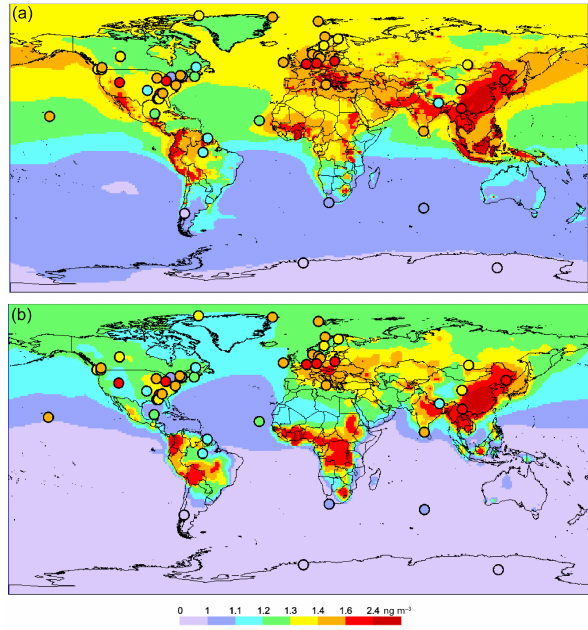
Figure 5. Global distribution of annual mean GEM concentration in near-surface air in 2013 simulated by GLEMOS (a) and ECH- MERIT (b) . Circles show observed values at ground-based moni- toring